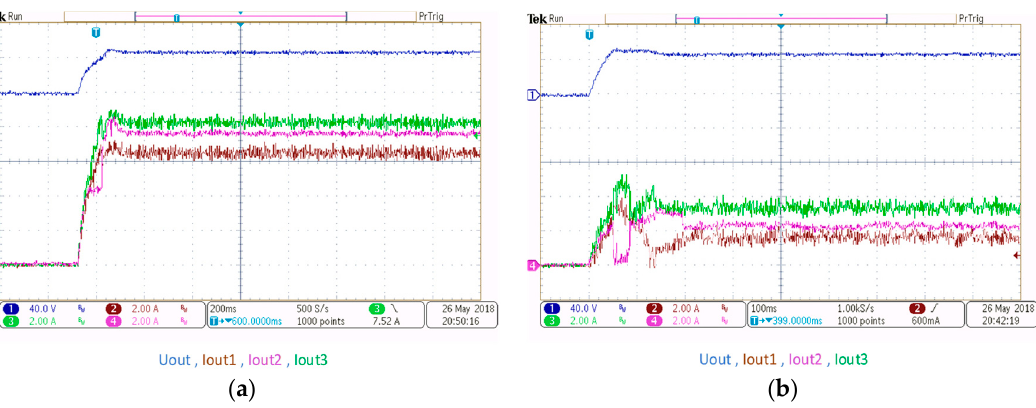
Figure 9. MAPS start-up sequence for frequency follower control strategy. ( a ) ( P OUT = 100%), ( b ) ( P OUT = 20%).